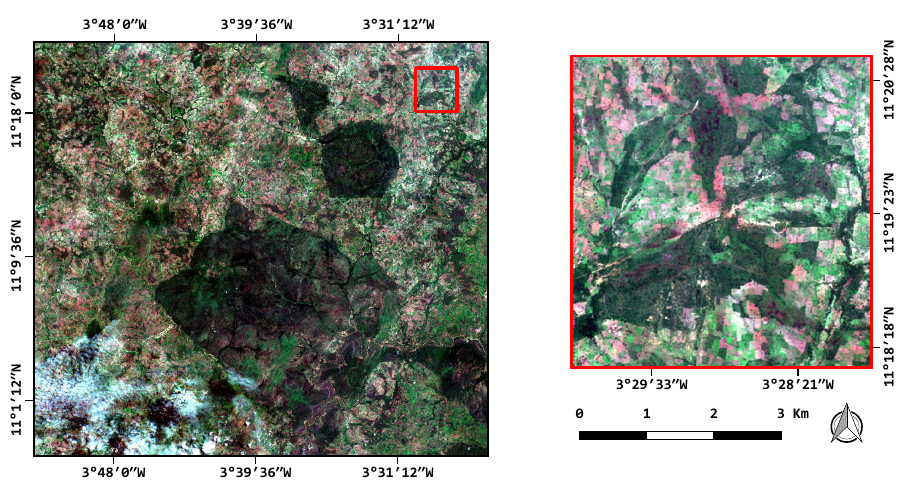
Figure 2. RGB representation of the 5253 the area selected for